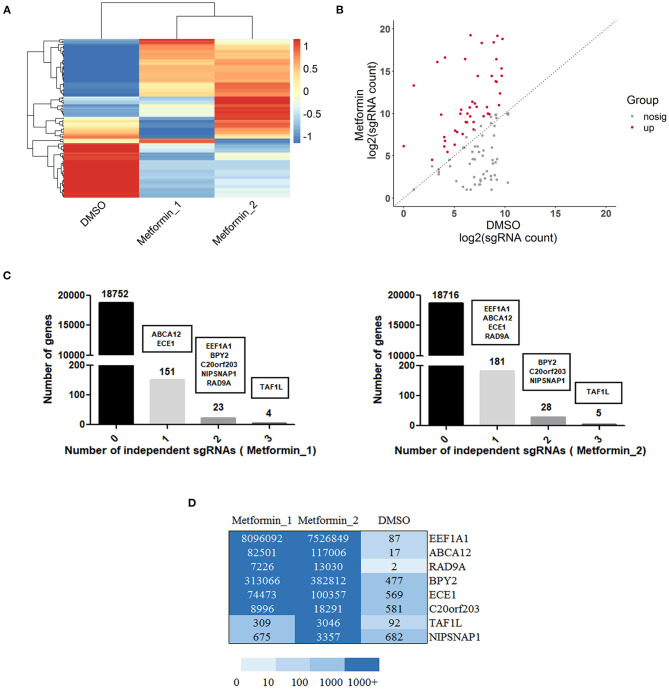
Gain of function screening in DU145 cells reveals genes that confer metformin resistance. (A) A heatmap displaying median-centered counts for differentially abundant sgRNAs; (B) scatter plot showing the significantly upregulated sgRNA enriched after metformin treatment; (C) number of genes with 0, 1, 2, or 3 significantly enriched resistant sgRNAs. Genes were selected by reads of sgRNA and sgRNA diversity, as shown in black boxes. (D) A heatmap displaying the resistant sgRNAs counts of the selected eight genes.